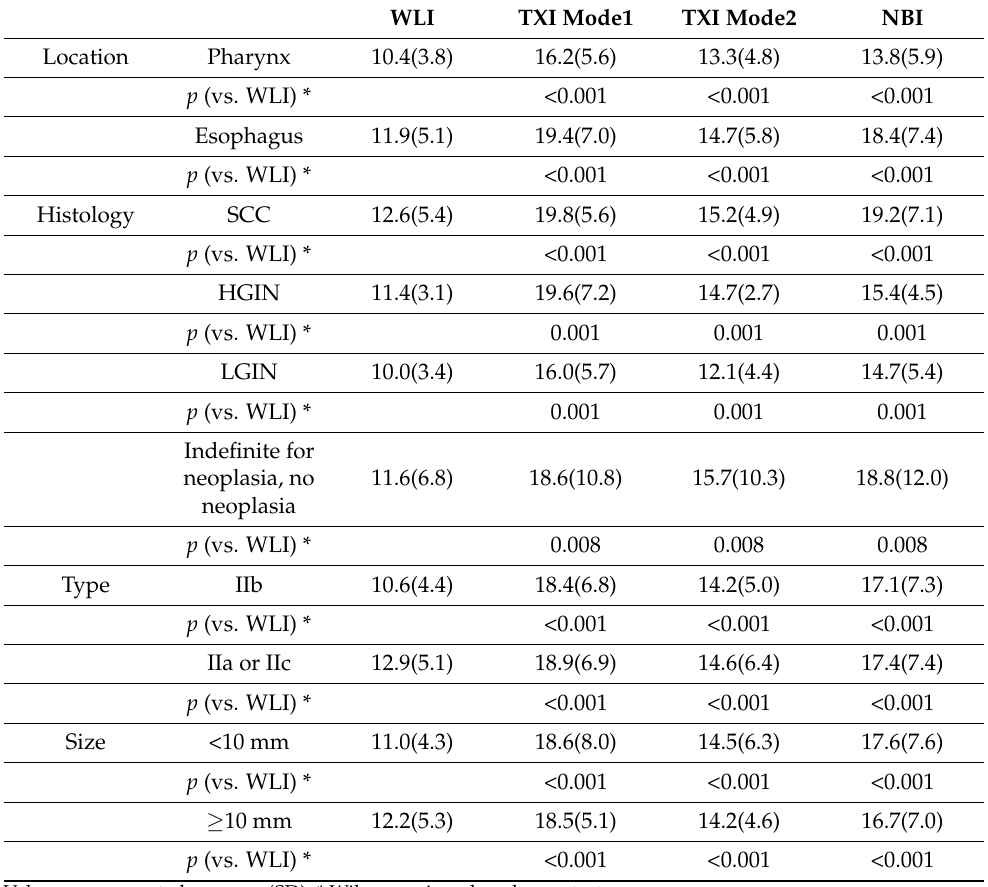
Table 3. The results of the comparisons of the color difference by location, histology, macroscopic type, and